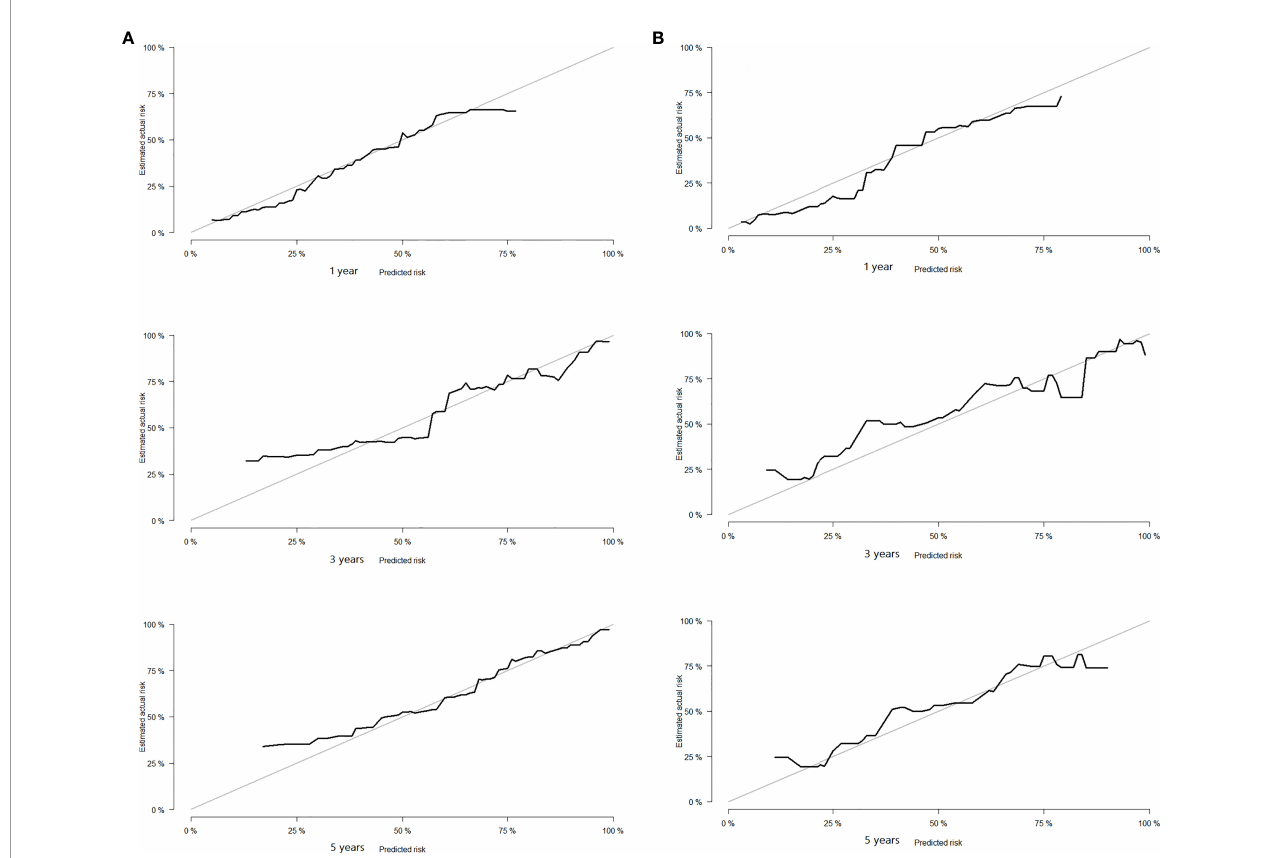
FIGURE 7 | The calibration curve of the prognostic nomogram in training (A) and validation sets (B)